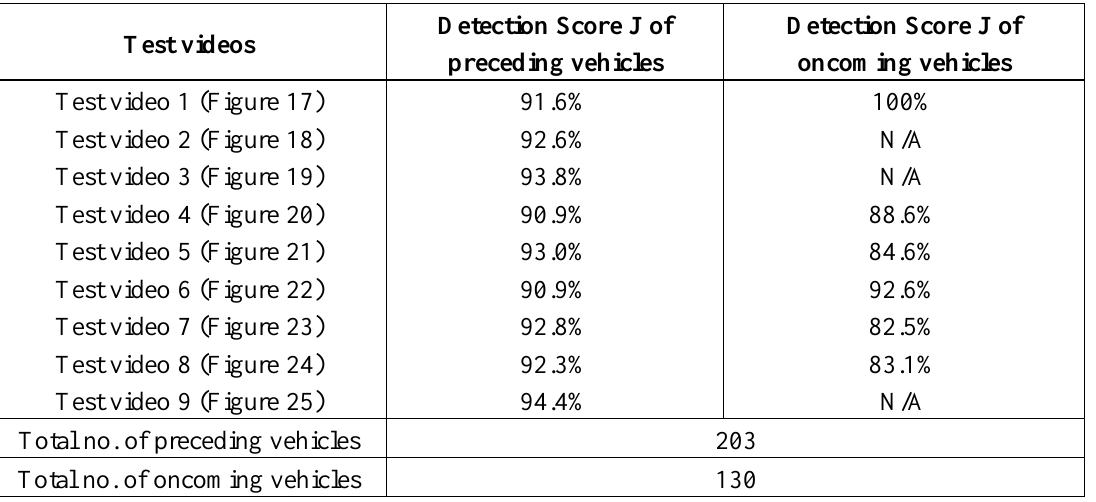
Table 1. Quantitative experimental data of the proposed system on detecting preceding and oncoming